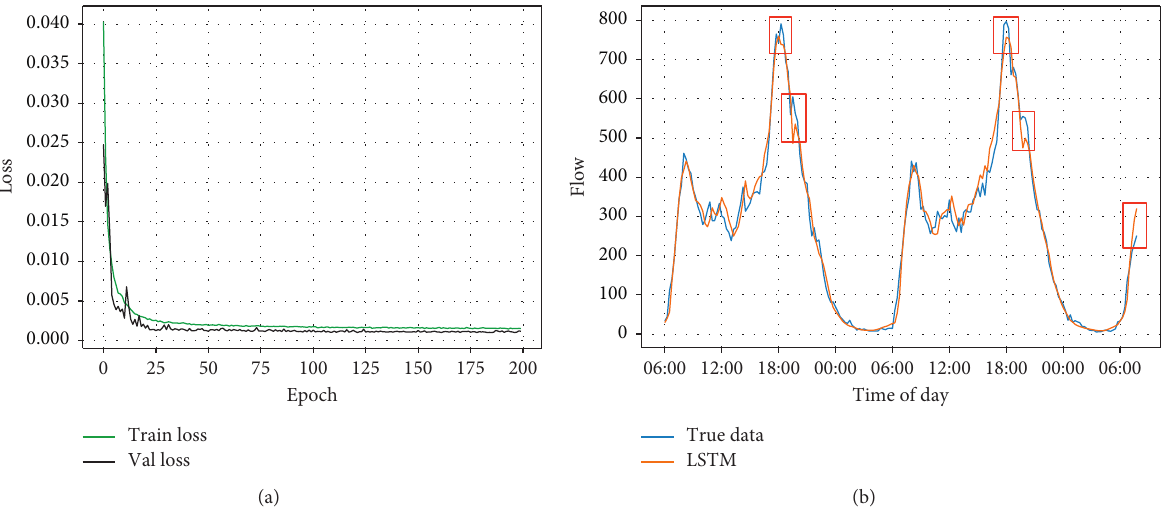
Figure 10: 12 steps LSTM training and prediction. (a) 12 steps LSTM loss function and (b) 12 steps LSTM prediction